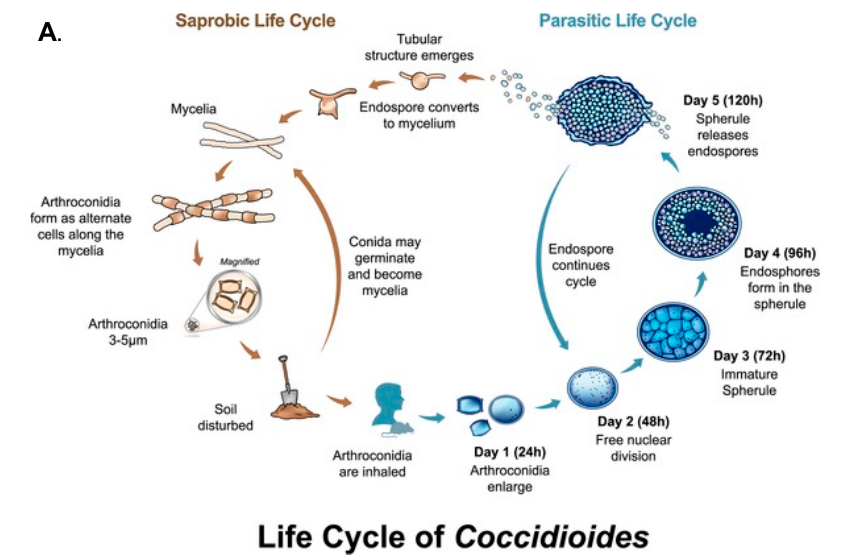
10 of 38 Figure 6. Components of arthroconidia cell wall. A and B: Thin sections of conidia of C. immitis showing differentiation of wall layers. OW, outer wall layer; SW, septal walls of conidium; ICW, newly formed inner conidial wall composed of the outer zone (OZ) and more homogeneous inner zone (IZ); RL, rodlet layer; Pm, plasmalemma. Arrow locates soluble conidial wall fraction (SCWF) trapped between OW and RL which is released during the cell-shearing process. A , magnification ×1,2000; B , magnification ×2,7000. The figure is from [64] and is reproduced with permission. C , composition of inner and outer cell wall and SCWF. The data for this figure is from [64] . 4.2. Spherules Differentiation into a spherule begins with the arthroconidium swelling into a round cell that then enlarges isotropically and divides internally to eventually form endospores.